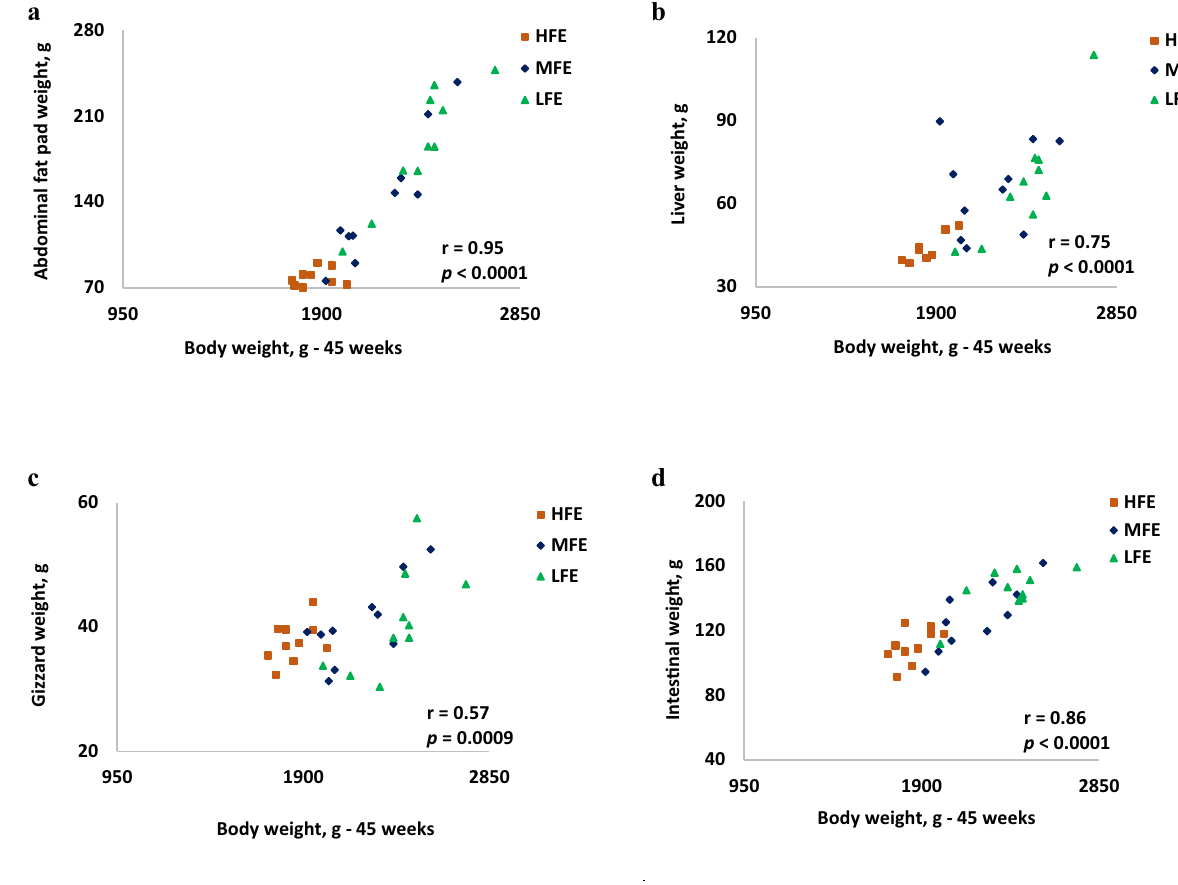
Figure 2. Correlation ( r ) between body weight at 45 weeks and ( a ) abdominal fat pad weight ( b ), liver weight ( c ) gizzard weight and ( d ) total intestinal weight of individually housed hens aged 45 weeks ranked based on differences in feed efficiency. (n = 30; 10 per FE group). HFE, High feed efficiency; MFE, Medium feed efficiency; LFE, Low feed efficiency; r = coefficient of correlation, p = level of significance.